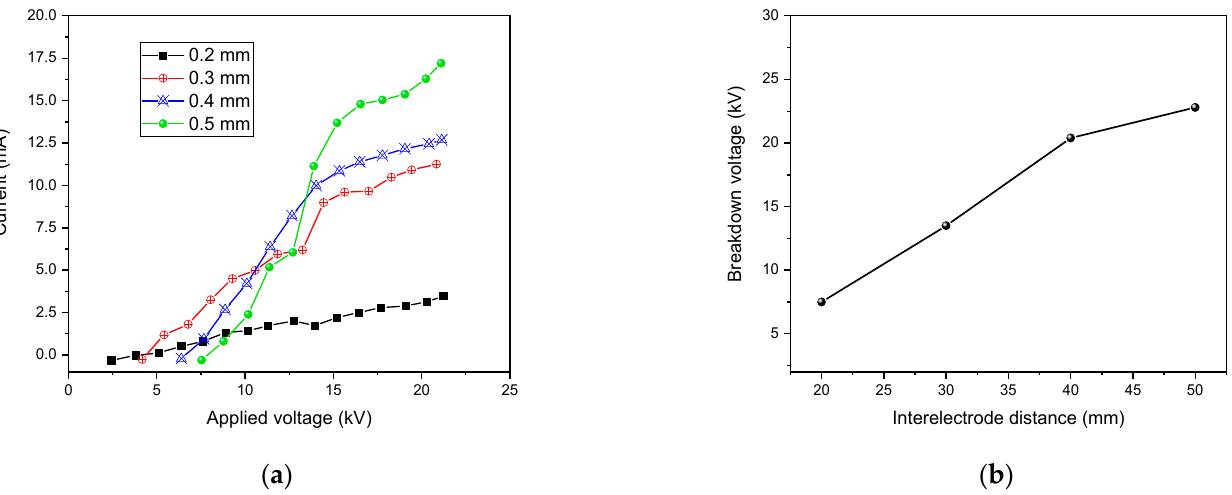
Figure 16. Variation of current of the DBD ( a ) and breakdown voltage as a function of the interelec- trode distance ( b ).